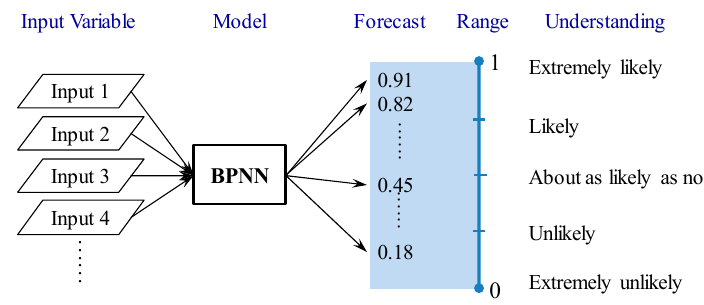
Figure 2. Probabilistic forecasting method.